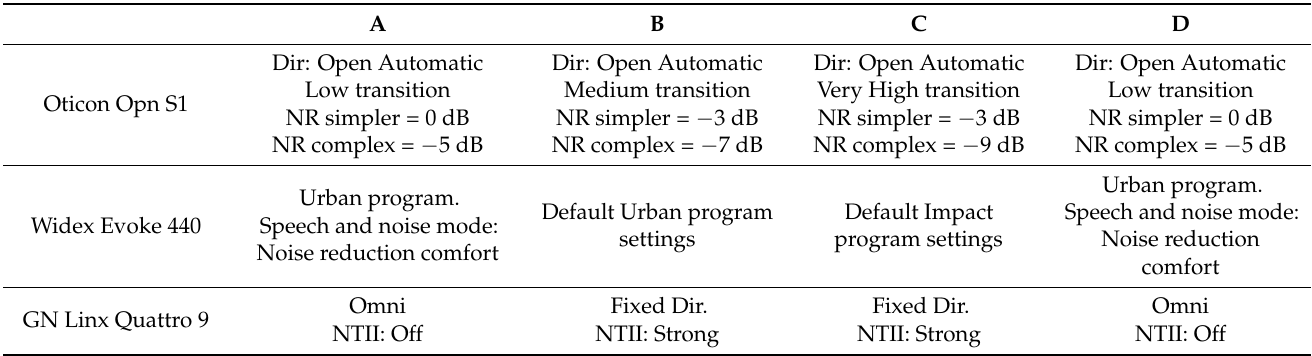
Table A1. Settings of the advanced features for each profile-based hearing-aid fitting.